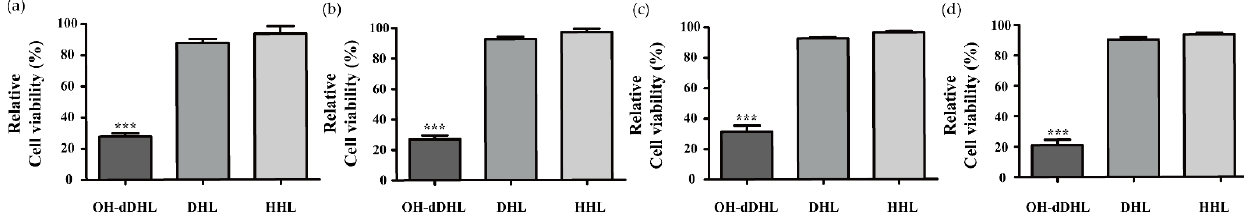
Figure 1 . Effect of C6-HSL (HHL), C10-HSL (DHL), and OH-dDHL on the cell viability of host cells. ( a ) BMDMs were treated with 50 µM AHLs for 24 h. ( b ) THP-1 cells, ( c ) A549 cells, and ( d ) HEp-2 cells were treated with 100 µM AHLs for 24 h and cell viability was measured with the CCK assay. Data are presented as mean ± SEM of three independent experiments. ***, p < 0.001 vs. DHL and HHL.